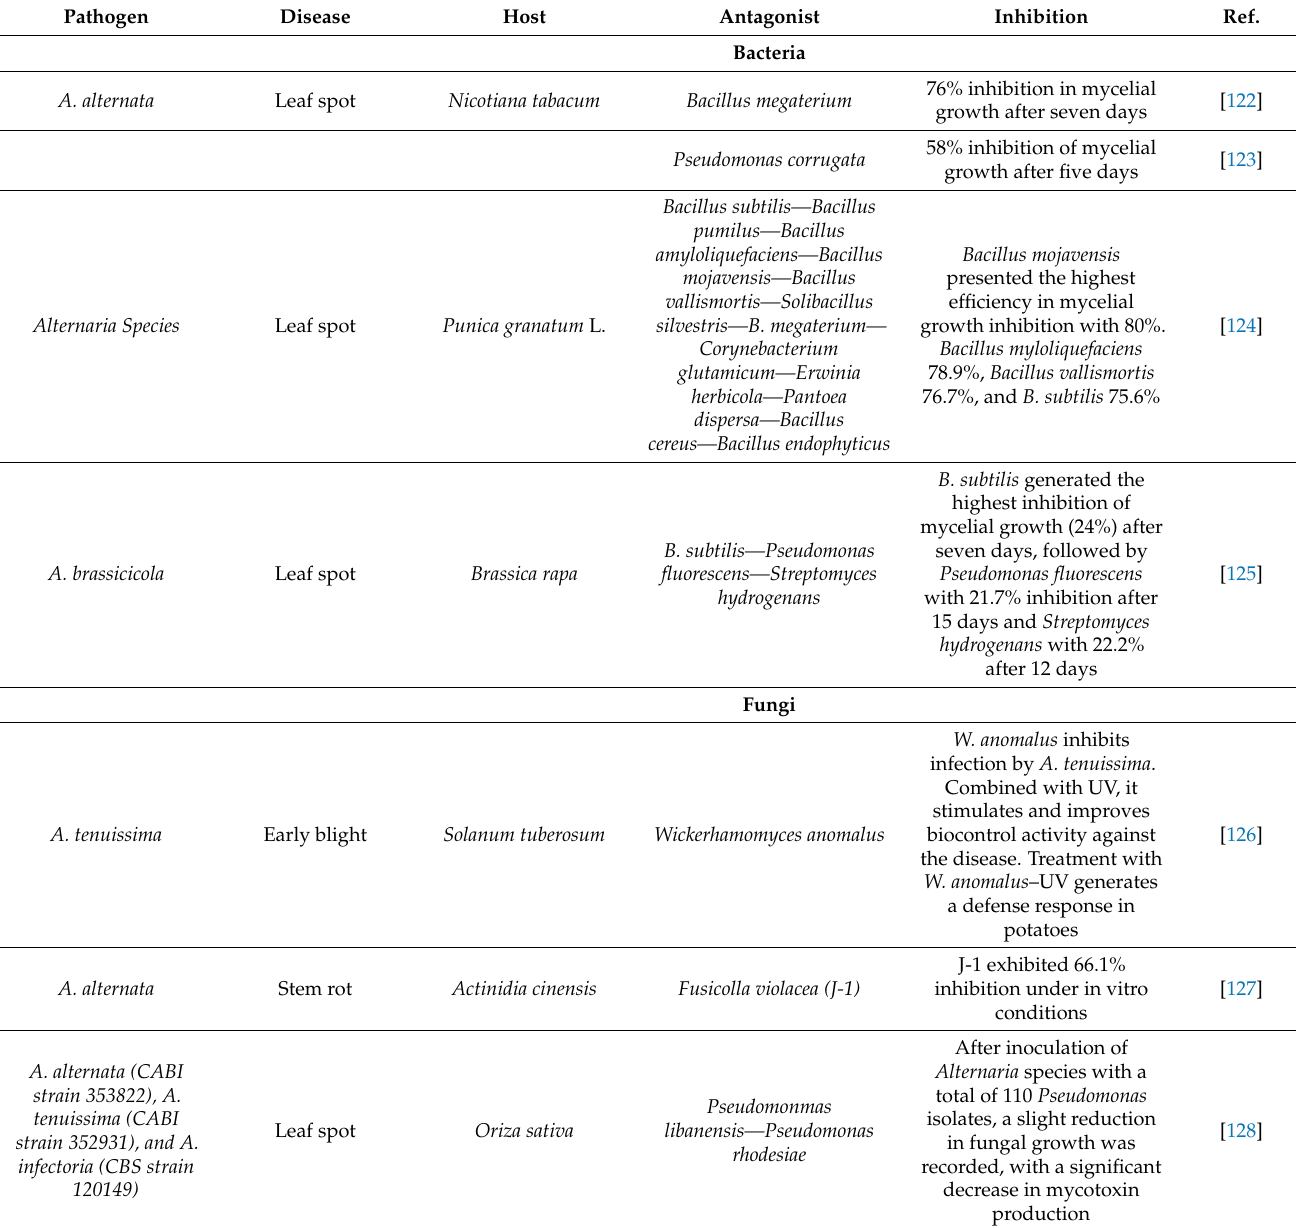
Table 3. Examples of fungi and bacteria for the biological control of Alternaria species in